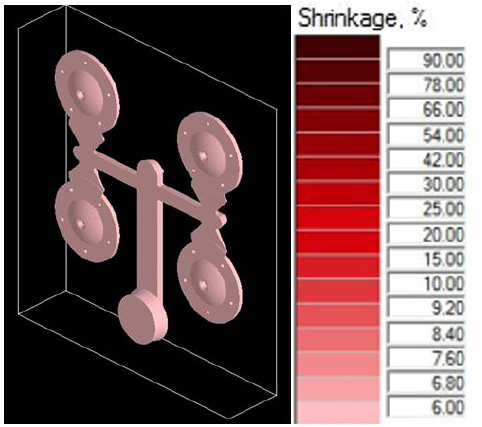
Figure 12. Distribution of defects in adjusted gating system—contractions 0%.